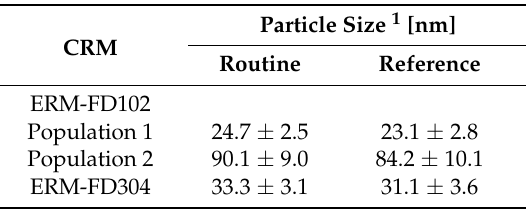
Table 2. Comparison of particle size results (mean ± expanded uncertainty) determined by routine and reference disc-CLS methods.